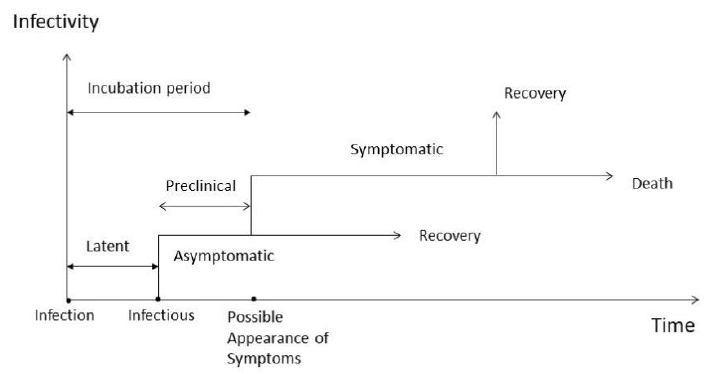
Figure 1. Timeline for infection and disease.